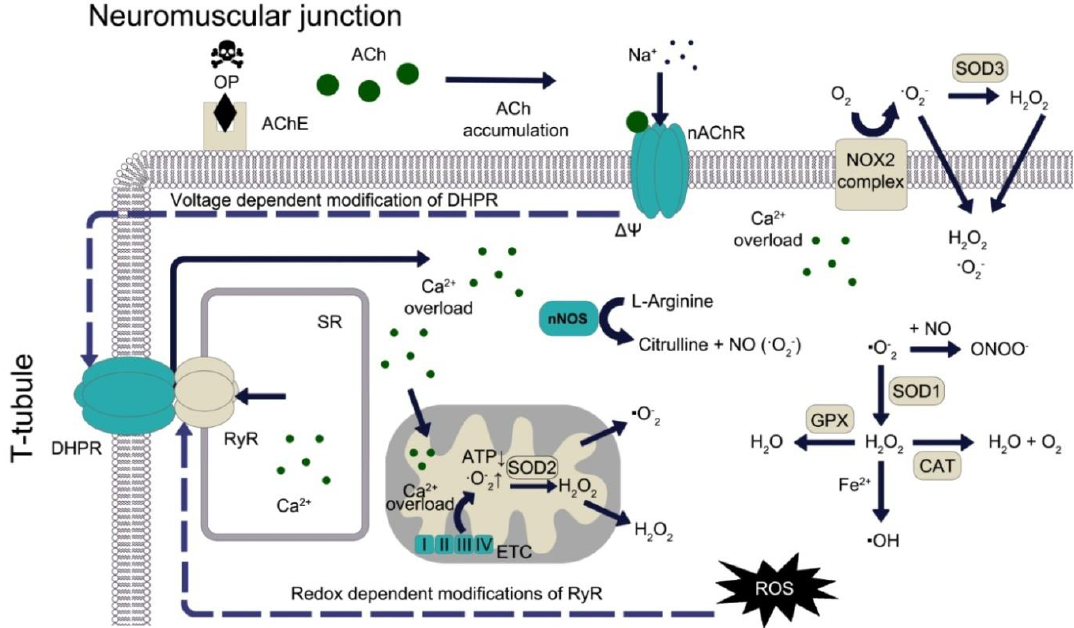
Figure 1. Role of reactive oxygen species (ROS) in the mechanism of toxic effects of organophosphates on skeletal muscle.